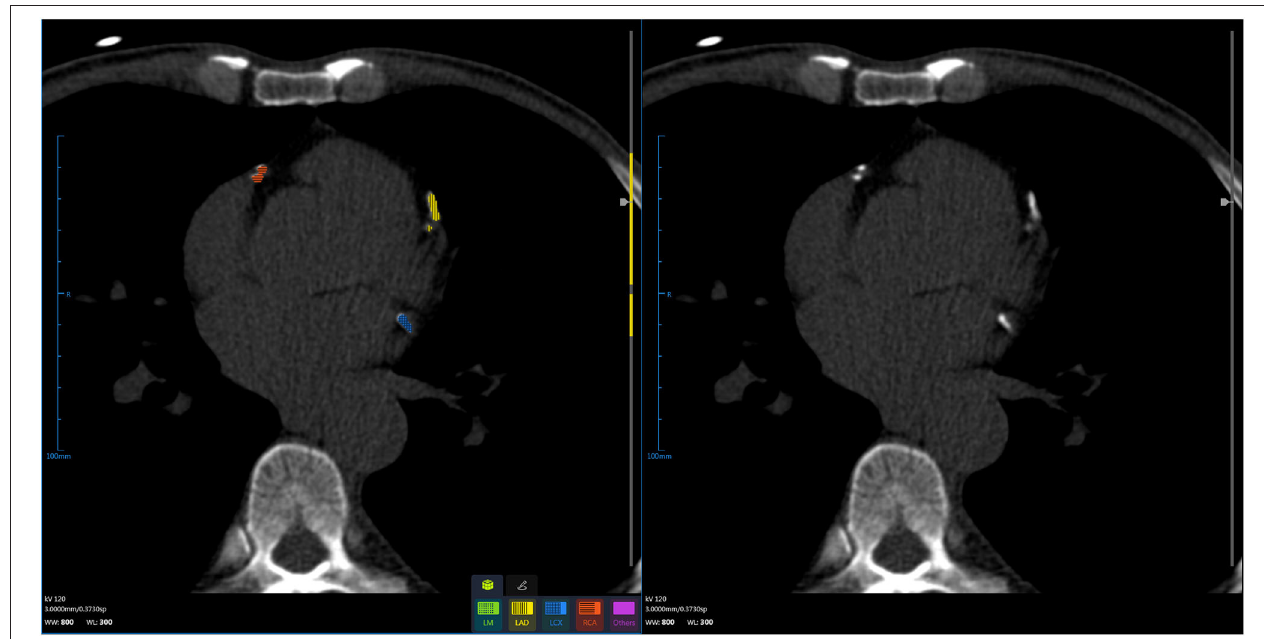
FIGURE 2 | Using artificial intelligence, coronary artery calcification is identified, segmented, and scored.